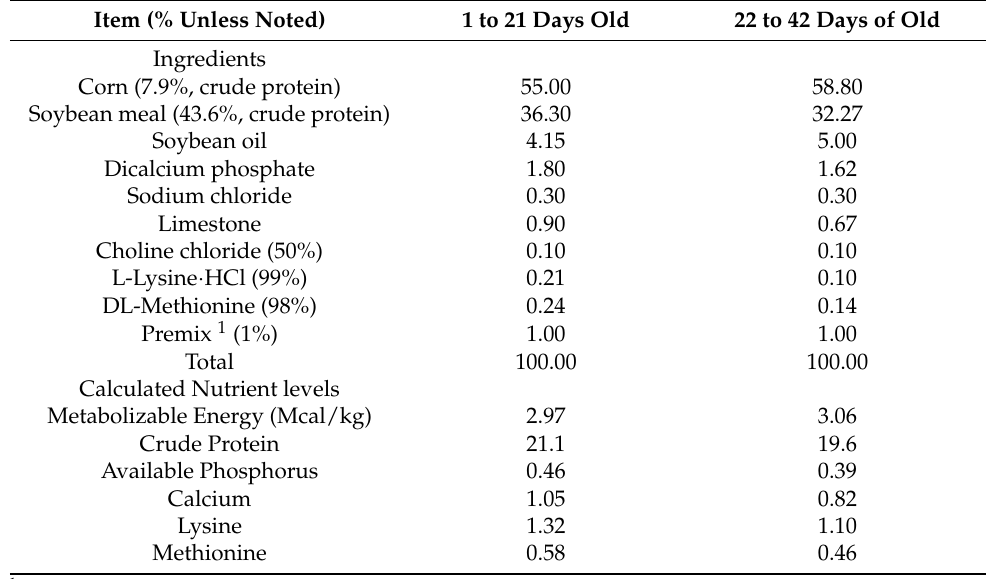
Table 2. Ingredient composition and nutrient levels of the basal corn–soybean meal